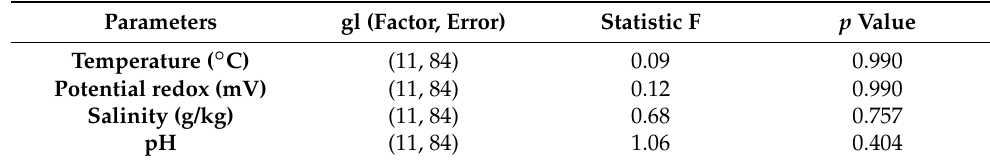
Table 1. Analysis of variance (ANOVA) of a pathway of the physicochemical parameters of the interstitial water in the ponds during the conditioning and afforestation phase of the seedlings of Rhizophora mangle ( p <